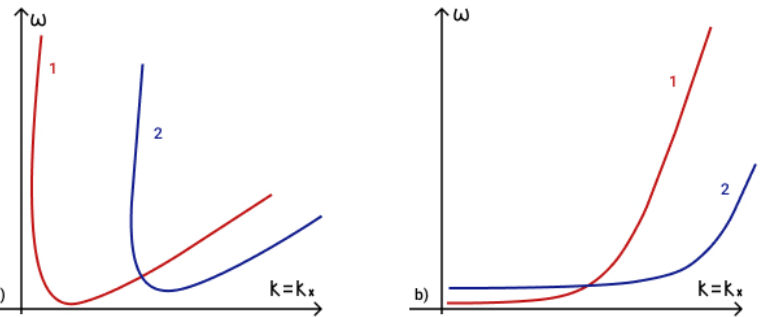
Figure 5. Phase matching condition for three magneto-Rossby waves in ( a ) external vertical magnetic field and ( b ) horizontal magnetic field: 1 — ω = ω ( k x ) , 2 — ω = ω ( k x − k x